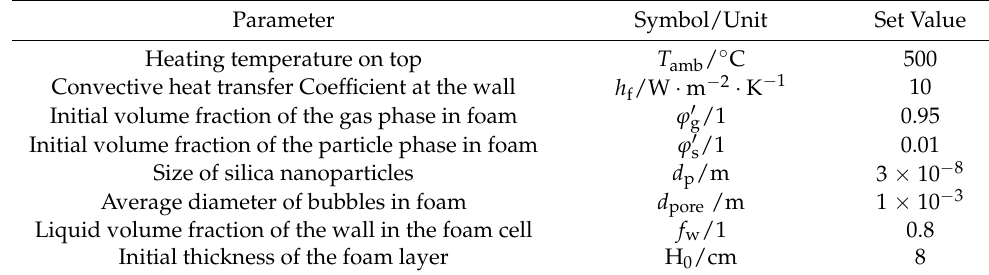
Table 1. Parameters of the typical operating